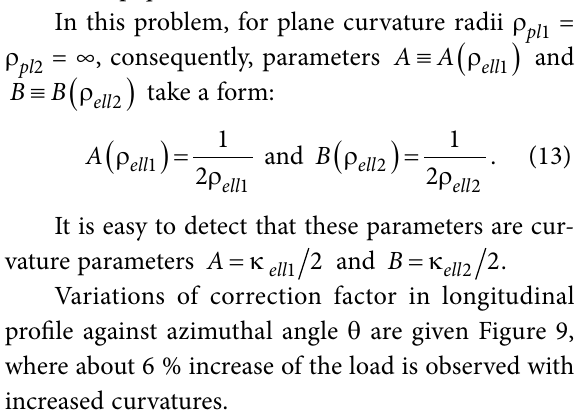
Fig. 7. Variation of curvature radii in longitudinal section presented in spherical coordinates a) radius ρ perpendicular to cross-section profile to section profile, b) radius ρ 2